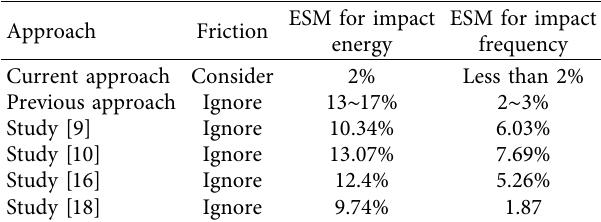
Figure 14: Comparison between measure and simulation of impact frequency. Table 3: Difference between the current approach and previous